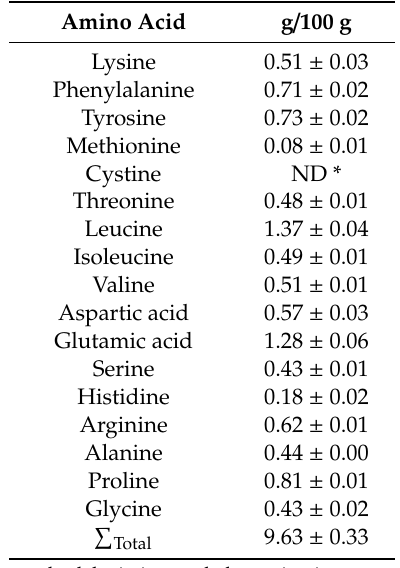
Table 5. Amino acid profile of teosinte flour.